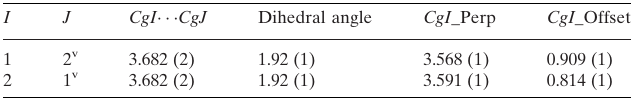
Table 3 (cid:3) – (cid:3) interactions (A˚ , (cid:4) ). Cg 1 and Cg 2 are the centroids of the C9/N10/C11–C14 and C1–C4/C11/C12 rings, respectively. CgI (cid:2)(cid:2)(cid:2) CgJ is the distance between ring centroids. The dihedral angle is that between the planes of the rings I and J. CgI _Perp is the perpendicular distance of CgI from ring J. CgI _Offset is the distance between CgI and the perpendicular projection of CgJ on ring I